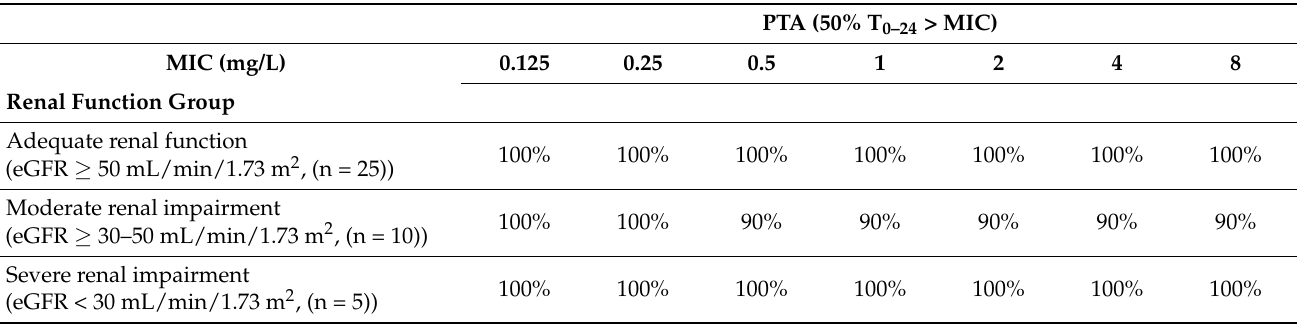
Table 4. Probability of PK/PD target attainment of 50% T > MIC for the first 24 h of treatment based on the observed data in the different renal function groups using different MIC values of common Gram-negative bacteria susceptible to ceftazidime as listed in the